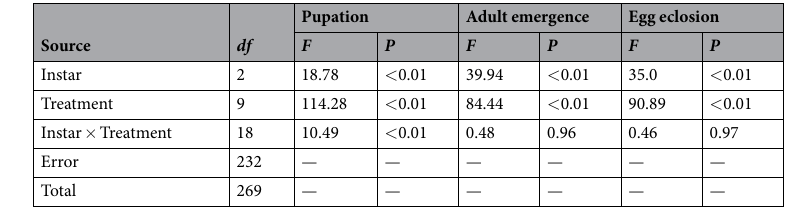
Development of R. ferrugineus : focus on last instar. Based on repeated measures analysis (and Tukey’s separation), diet consumption by 10 th instar was significantly influenced by the treatments applied ( F 3, 63 = 250.67, P < 0.01); diet consumption was lowest in the combined treatment of H. bacteriophora and B. bassiana compared to their sole applications and all treatments had lower consumption than the control (Fig. 1). Similarly frass pro- duction was influenced by treatments applied ( F 3, 69 = 386.22, P < 0.01), with the lowest frass production for the combined treatment of H. bacteriophora and B. bassiana (0.57 ± 0.04 to 0 ± 0.00 g) and highest in the control (the single-applied treatments were intermediate and not different from each other) (Fig. 2). Untreated larvae (con- trol) and larvae treated with sub-lethal concentrations of B. bassiana and H. bacteriophora gained more weight as compared to their combined application ( F 3, 24 = 56.77, P < 0.01) (Fig. 3); the single applied treatments were not different from the control whereas the combination treatment was statistically separated from all three others.